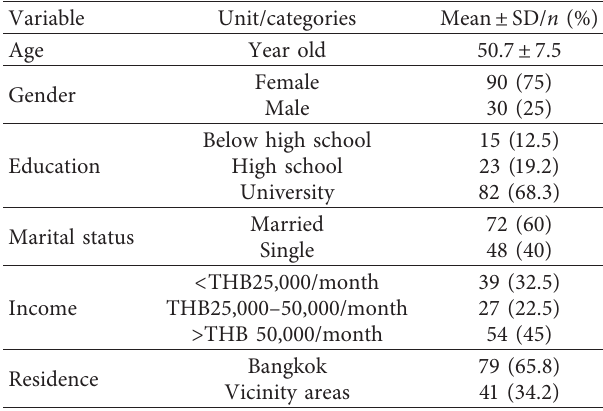
Table 1: Participant characteristics.